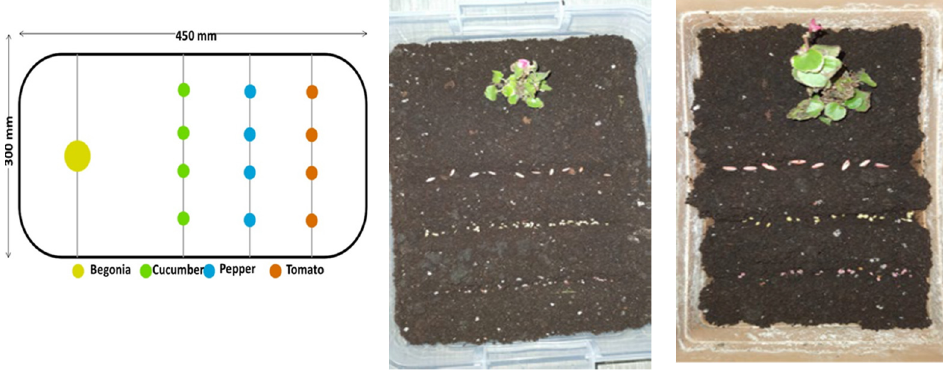
Figure 1. Planting order of begonia and three of the vegetables in the greenhouse and the pot.